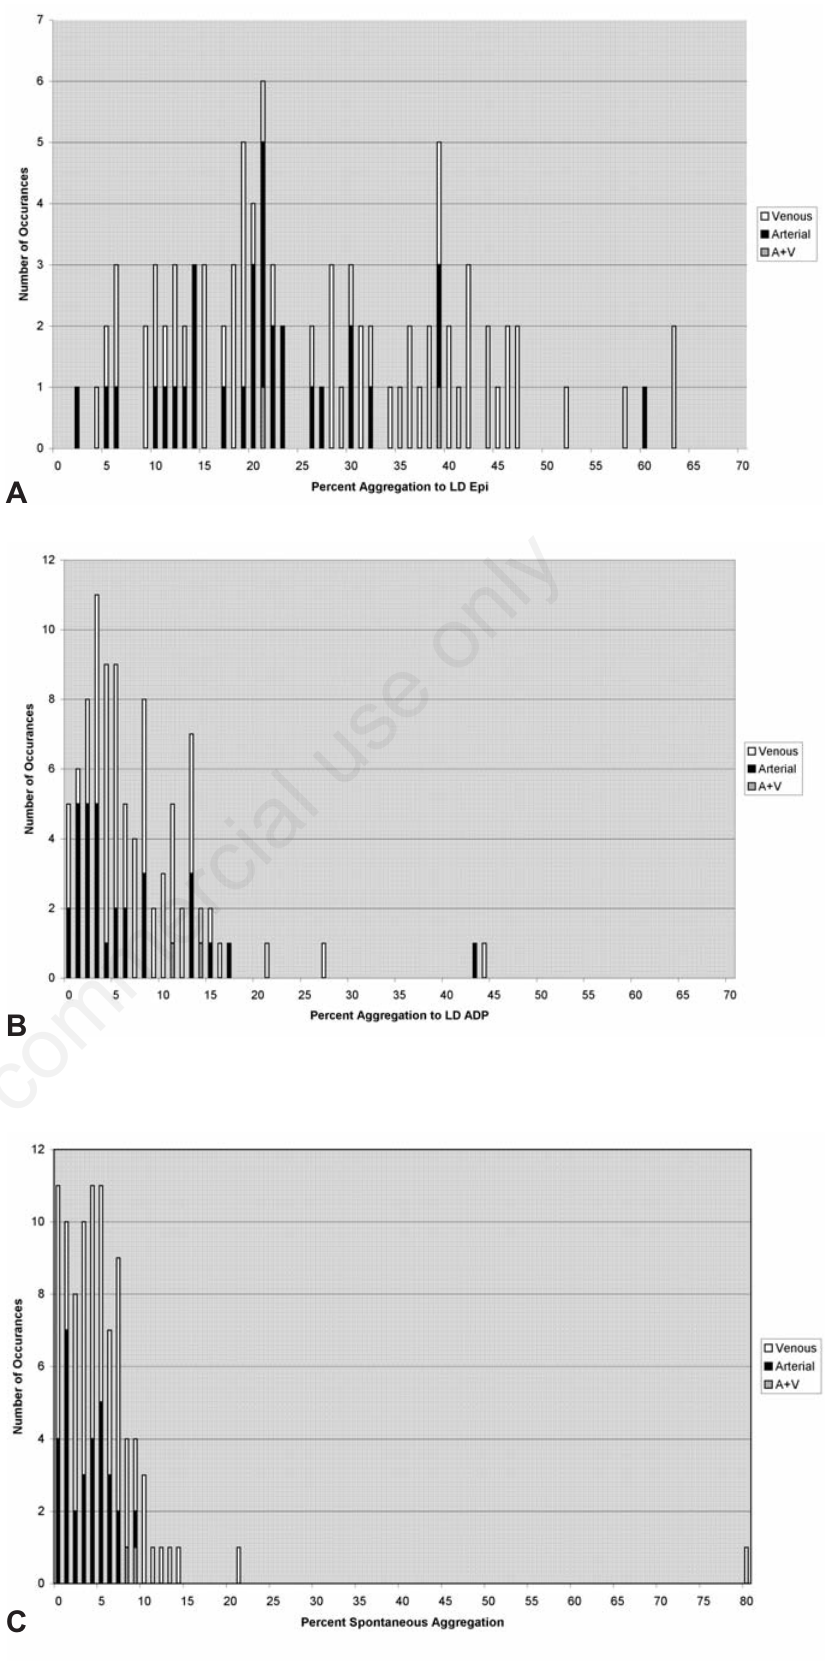
Figure 1. Distribution of aggregation response to: A) low-dose epinephrine; B) low-dose adenosine diphosphate; C) no agonist ( i.e.